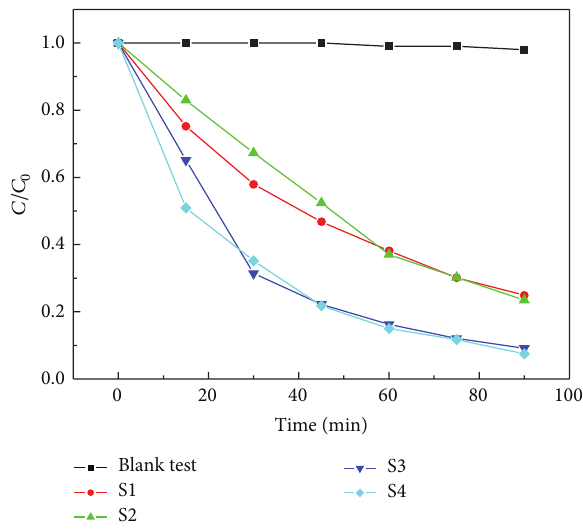
Figure 4: Photocatalytic degradation ratio of MB versus irradiation time by using various